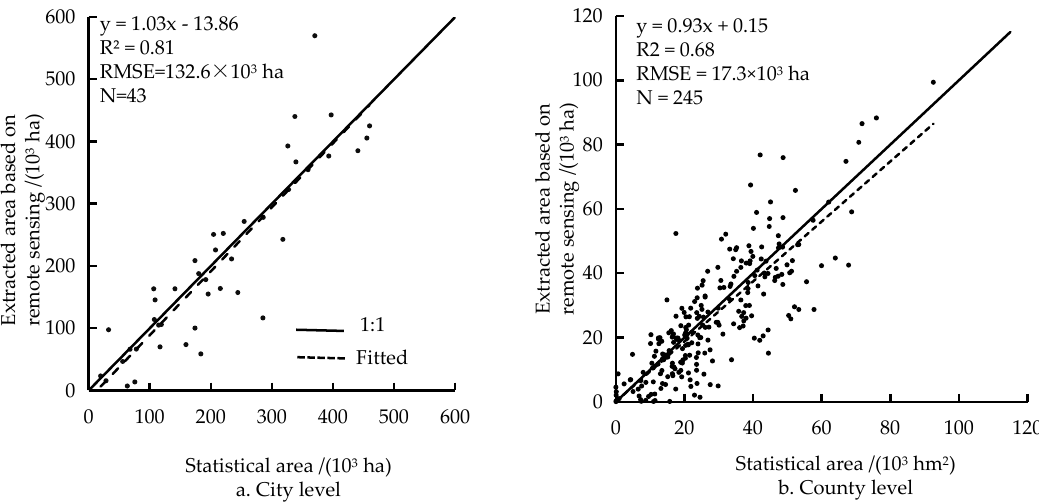
Statistical area /(10 3 ha) a. City level Figure 13. Correlation between the extracted area based on remote sensing and statistical area of summer maize in Huanghuaihai Plain in 2013; ( a ) City level, ( b ). County level. Table 7. Comparison of extracted area and statistical data of summer maize for each province in 2013. Statistical Province Area / 10 3 Province